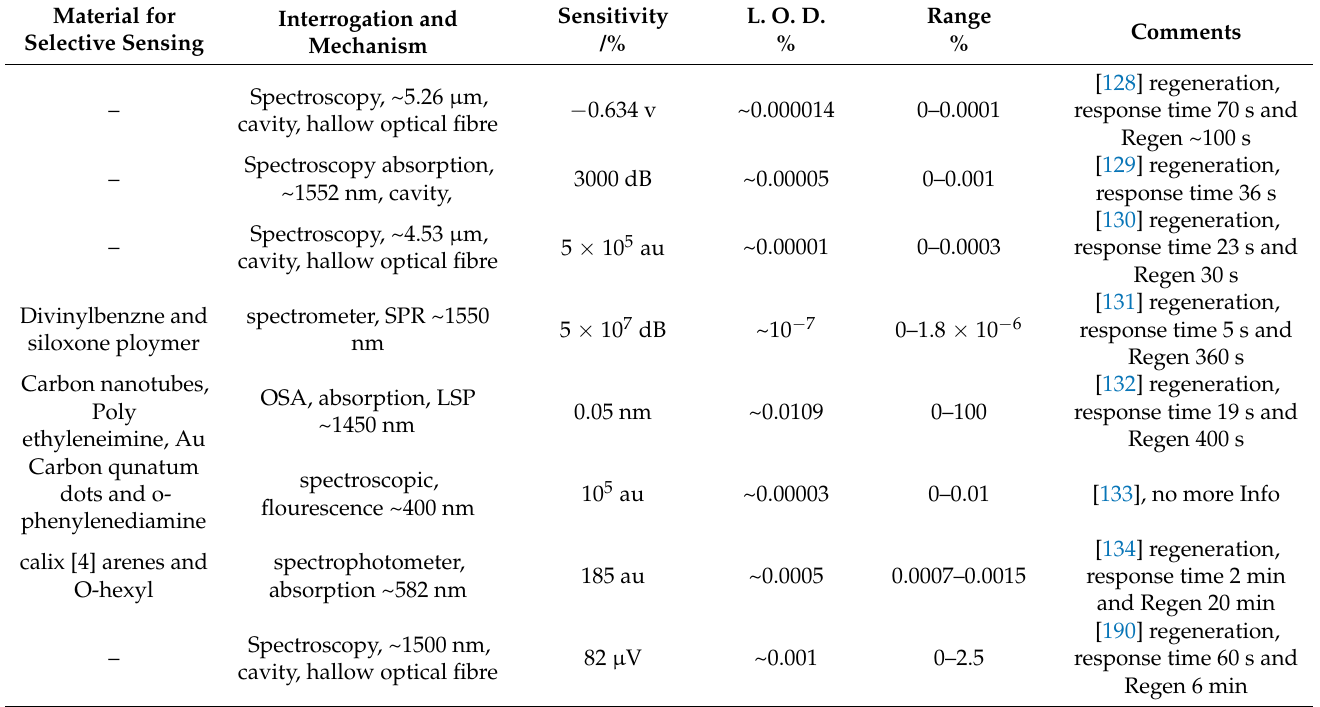
Table 3. Summary of various optical fibre sensors for the detection of nitrous